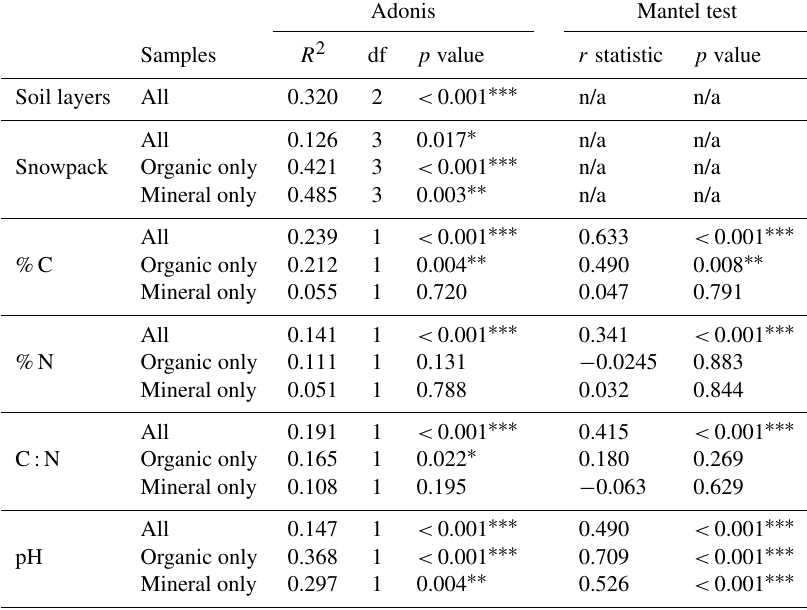
Table 2. Statistical analysis of beta diversity using adonis and Mantel tests. Bray–Curtis distance matrices of bacterial communities for each sample were compared between soil layers (organic, transition, mineral) and snow accumulation treatments (Control, Deep, Int., Low), and to soil chemical properties. Sample sizes were n = 15 for “Organic only”, n = 13 for “Mineral only”, and n = 41 for “All”. Significance is indicated by asterisks ( ∗ = p < 0.05, ∗∗ = p < 0.01, ∗∗∗ = p < 0.001)); “df”: degrees of freedom; “n/a”: not applicable. Adonis Mantel test